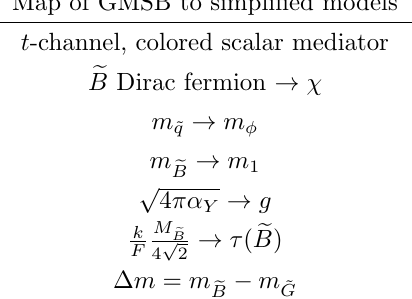
Table 5 . Map of the simpli(cid:12)ed models parameters to GMSB. The (cid:12)rst (cid:12)ve rows characterise the DM simpli(cid:12)ed model while the last two rows are the additional parameters required by the displaced vertices simpli(cid:12)ed